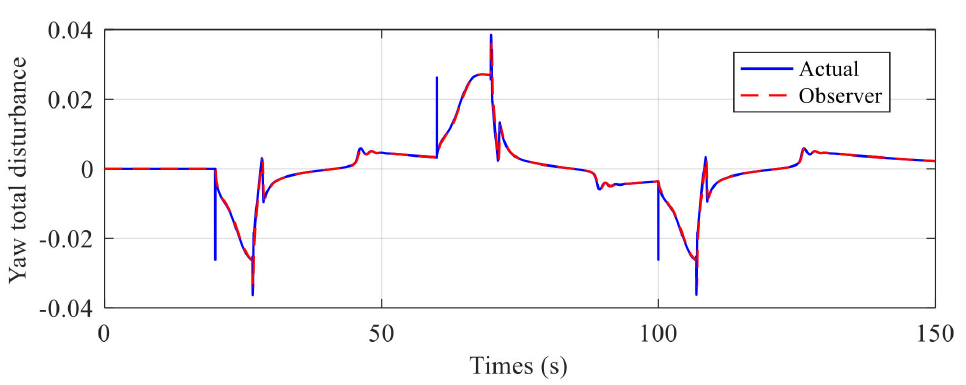
Figure 12. The estimation of the total disturbances of the